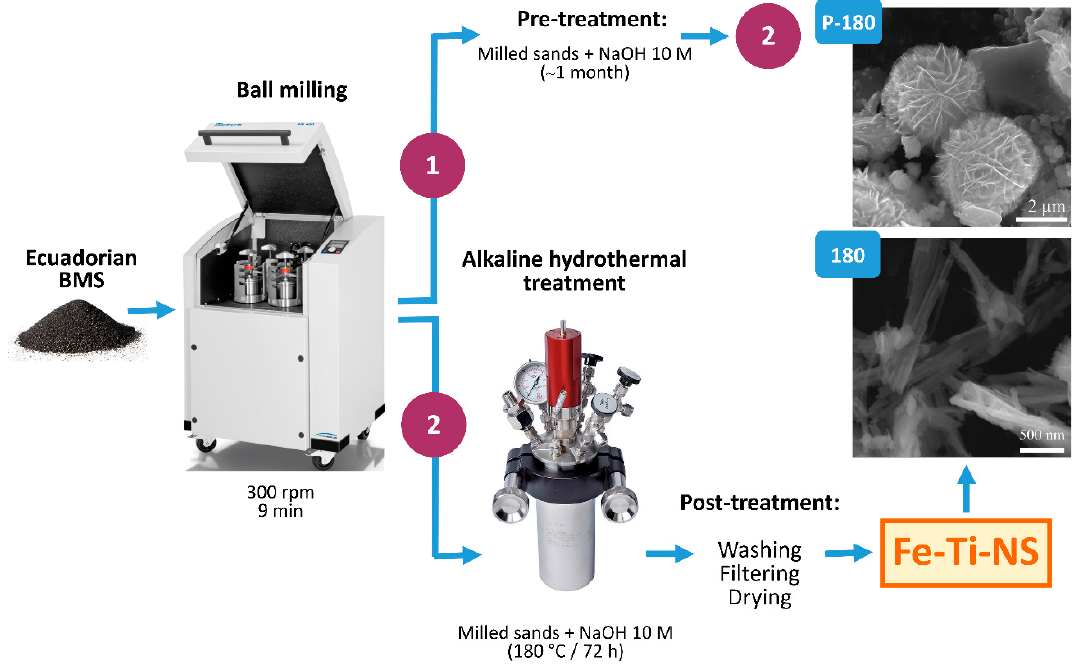
Figure 1. Schematic representation of Ecuadorian black mineral sands (BMS) processing to synthetize Fe ‐ Ti ‐ NS.